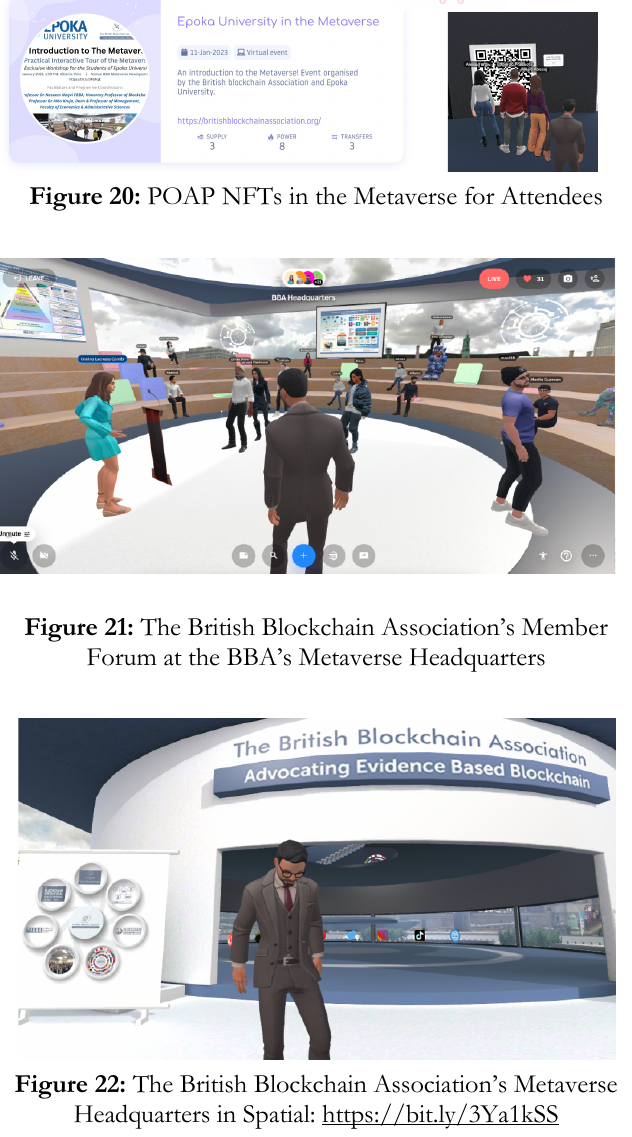
Figure 24: Prof Naqvi at a Synagogue in the